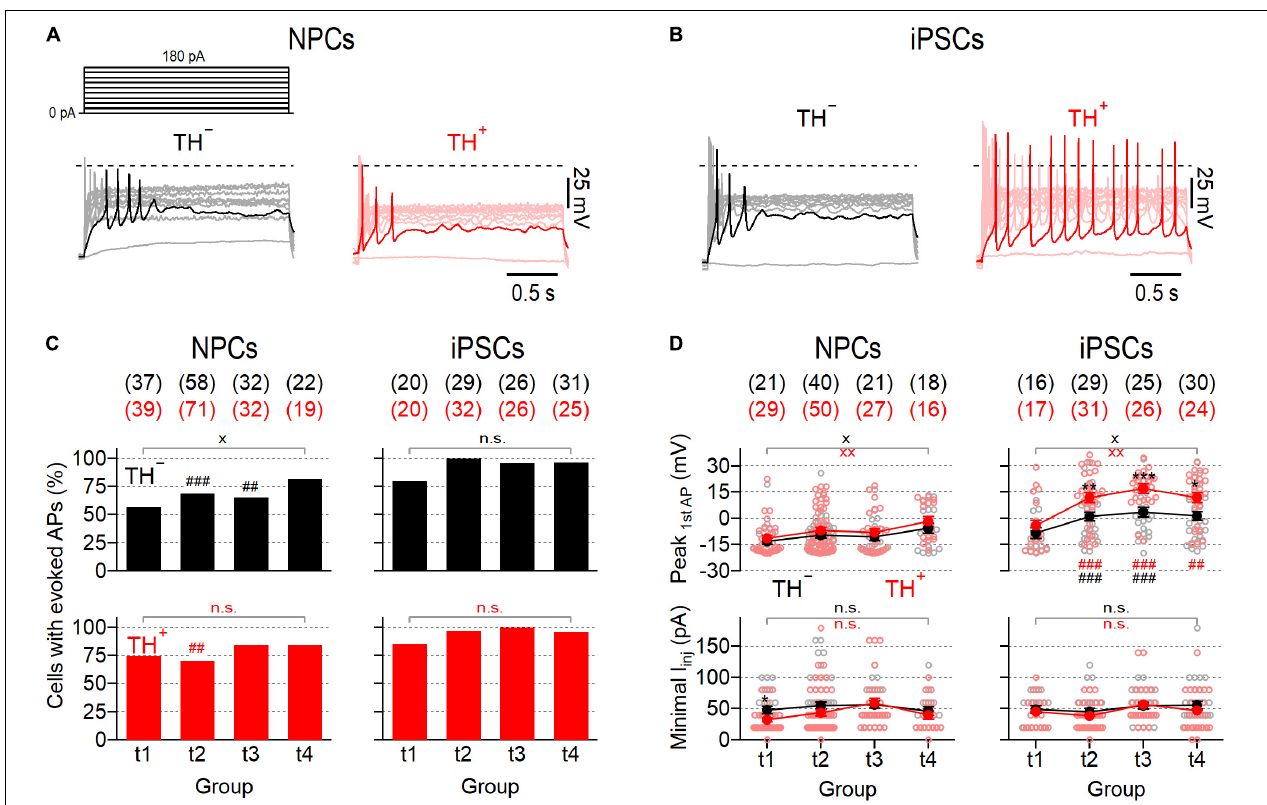
FIGURE 4 | Evolution of evoked action potential responses in NPC- and iPSC-derived dopaminergic cultures. (A) Representative voltage responses ( bottom ) of TH − ( left ) and TH + ( right ) NPC-derived neurons at time point 3 (t3) to 2 s current injections ranging from 0 to 180 pA ( top ). The 20 pA stimulation step is shown bold in the pulse protocol, corresponding voltage responses are highlighted in black (TH − ) and red (TH + ). (B) Identical recordings as in (A) , from TH − and TH + iPSC-derived neurons at t3. (C) Percentage of NPC- ( left ) and iPSC-derived ( right ) TH − ( top, black) and TH + ( bottom, red) neurons that responded to 2 s current injections of up to 180 pA with one or more APs, analyzed at specified time points. (D) Mean minimal current ( bottom ) required to evoke APs as shown in (A,B) and associated mean peak voltages ( top ) of the first AP fired, analyzed at indicated time points. Filled circles represent means ± s.e.m, connected with straight lines for clarity. Open circles indicate data obtained from individual cells. The numbers of cells analyzed in (C,D) are provided in parentheses. Statistical indicators in (C,D) refer to Fisher’s exact test or a Mann–Whitney U -test, respectively: *** P < 0.001, ** P < 0.01, * P < 0.05 for testing TH − against TH + neurons of the same line; xx P < 0.01, x P < 0.05, n.s. for comparing data obtained at t1 with data from t4; ### P < 0.001, ## P < 0.01 for testing data obtained with iPSC-derived neurons against data from NPC-derived